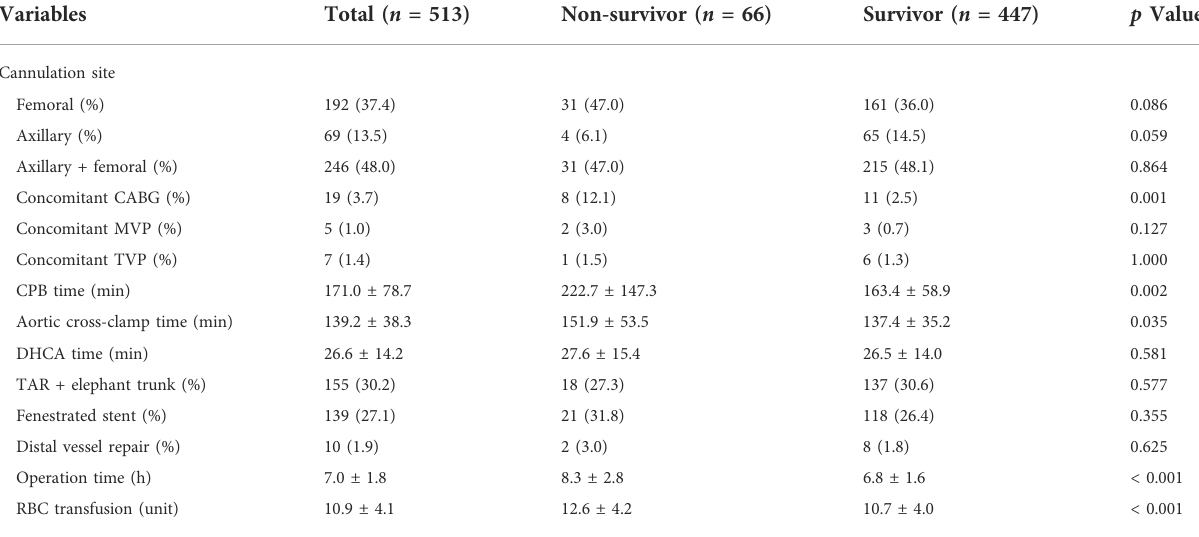
TABLE 2 Comparison of operative variables.